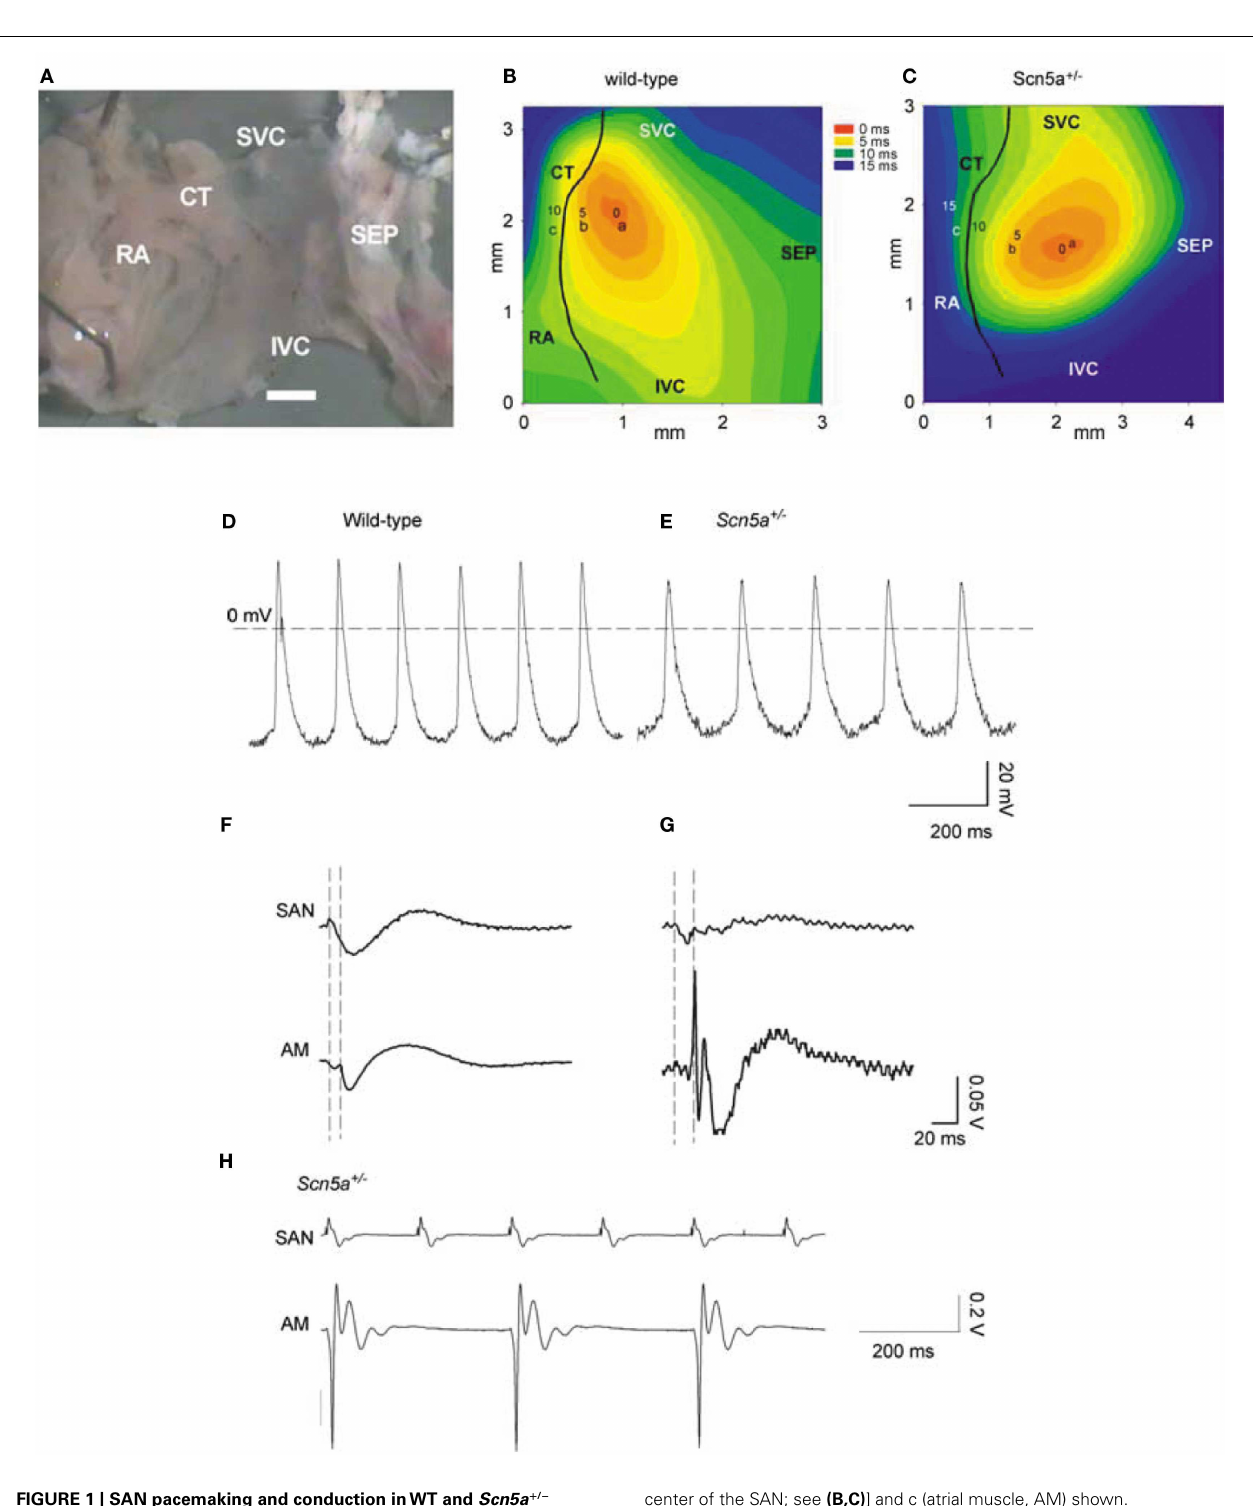
FIGURE 1 | SAN pacemaking and conduction inWT and Scn5a + / − mice. (A) Example of SAN preparation used for electrical mapping. Scale bar, 200 µ m. (B,C) Activation sequence in SAN ofWT and Scn5a + / − . (D,E) Action potentials recorded from sites near the center of the SAN in (A,B) fromWT (left) and Scn5a + / − (right) SAN preparations. (F,G) SAN conduction inWT and Scn5a + / − preparations. Extracellular potentials from sites a [leading pacemaker site in the